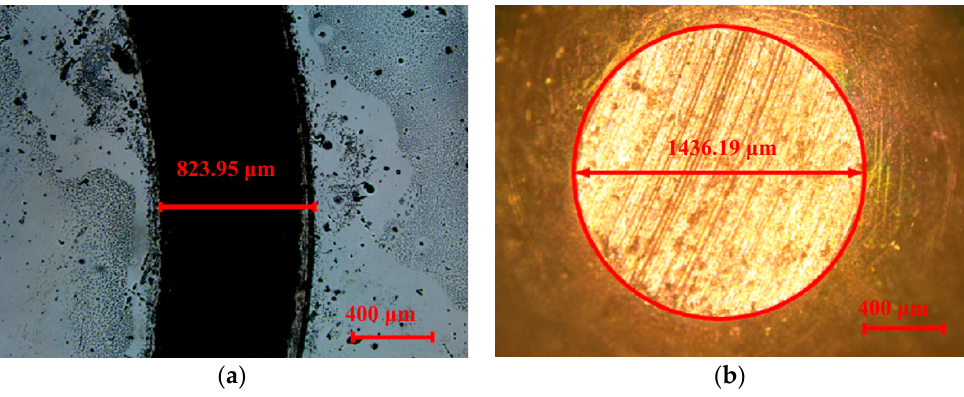
Figure 6. Images of wear scar of DLC films on steel ball/a-Si:H films at 600 °C: ( a ) disc; ( b ) ball.